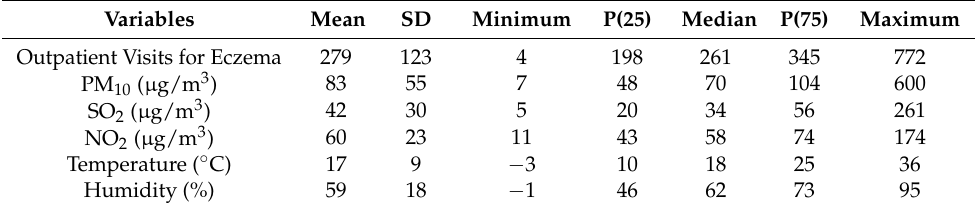
Table 1. Summary statistics of outpatient visits for outpatient visits for eczema, air pollutant concentrations and meteorological